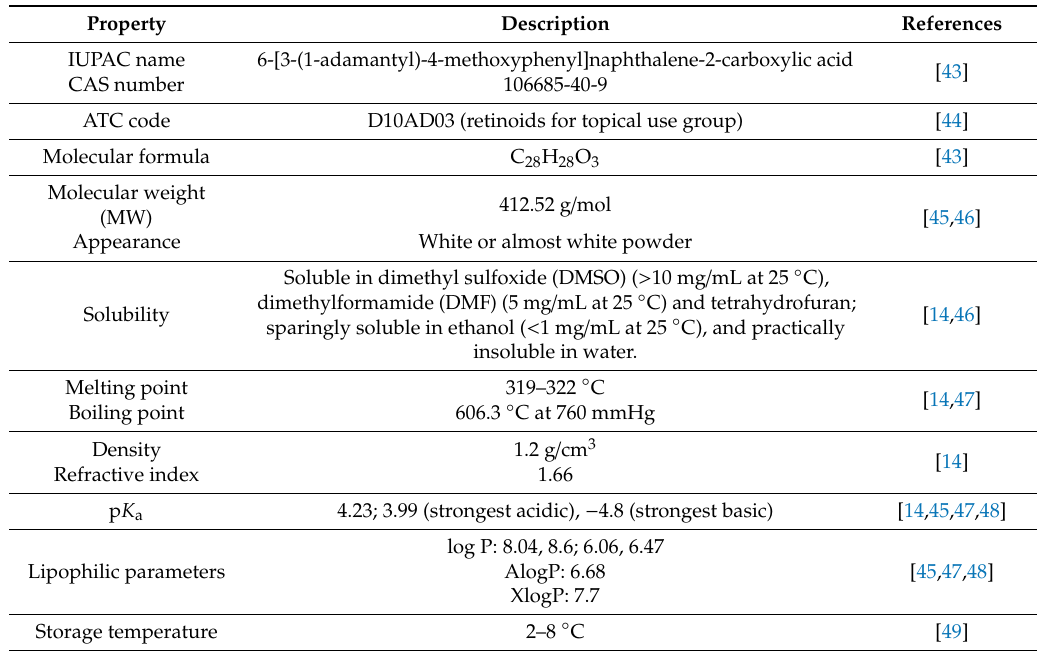
Table 2. Physicochemical properties of adapalene